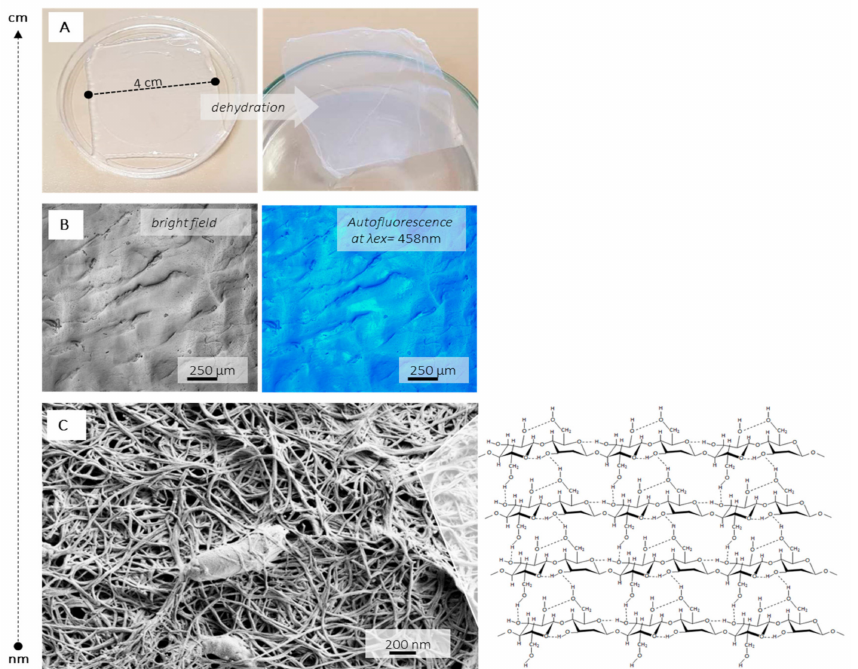
Figure 4. Di ff erent length-scale presentation of BC: ( A ) photographs of wet (left) and dry (right) BC membrane, ( B ) confocal fluorescent microscopy (CFM) image obtained under argon laser excitation at 458 nm from bright field and fluorescence channel, utilizing the cellulose autofluorescence and ( C ) high magnification scanning electron microscopy (SEM) image presenting entrapped K. xylinus bacteria and cellulose backbone